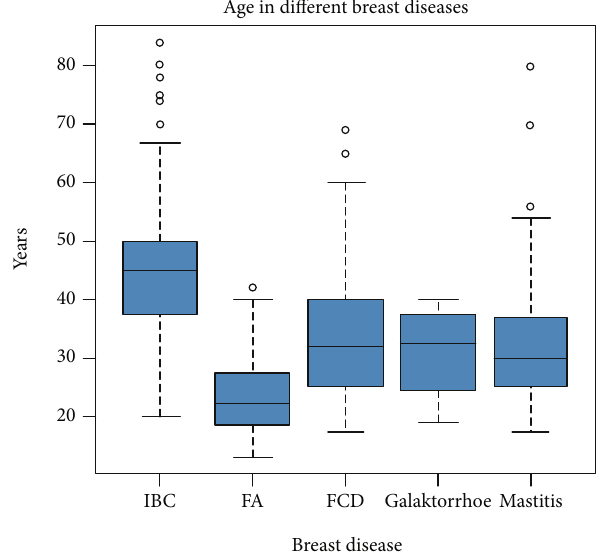
Figure 1: Age distribution in North Afghanistan breast diseases. IBC: invasive breast cancer: FA: fi broadenoma; FCD: fi brocystic diseases. Circles signify outliner, and the horizontal labels are the range without outliners. The blue boxes signify the 25 to 75